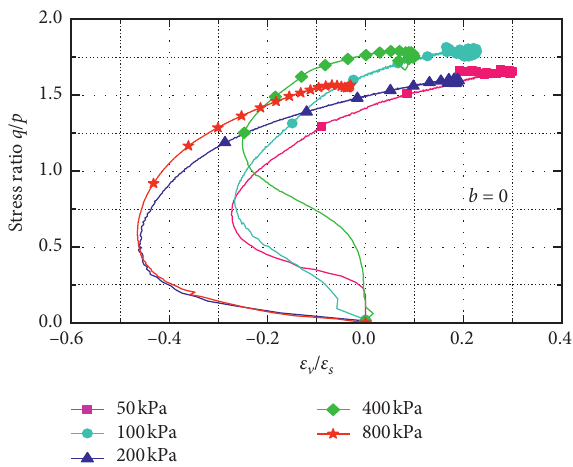
1 under different σ 3 .